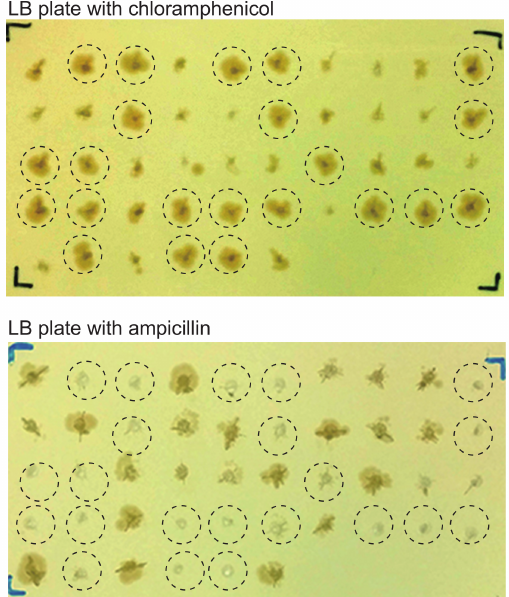
Figure 4. Bacterial colonies harboring EBV-BAC clones are larger than those harboring donor plasmids. EBV-positive gastric cancer cell line SNU-719 was subjected to EBV-BAC cloning. Individual chloramphenicol-resistant bacterial colonies obtained by transforming E. coli with episomal DNAs were picked up and transferred to LB plates containing either chloramphenicol (12.5 µ g/mL) or ampicillin (200 µ g/mL). Note that E. coli colonies growing faster on a chloramphenicol plate ( top ) are ampicillin-sensitive ( bottom ) (indicated by dotted